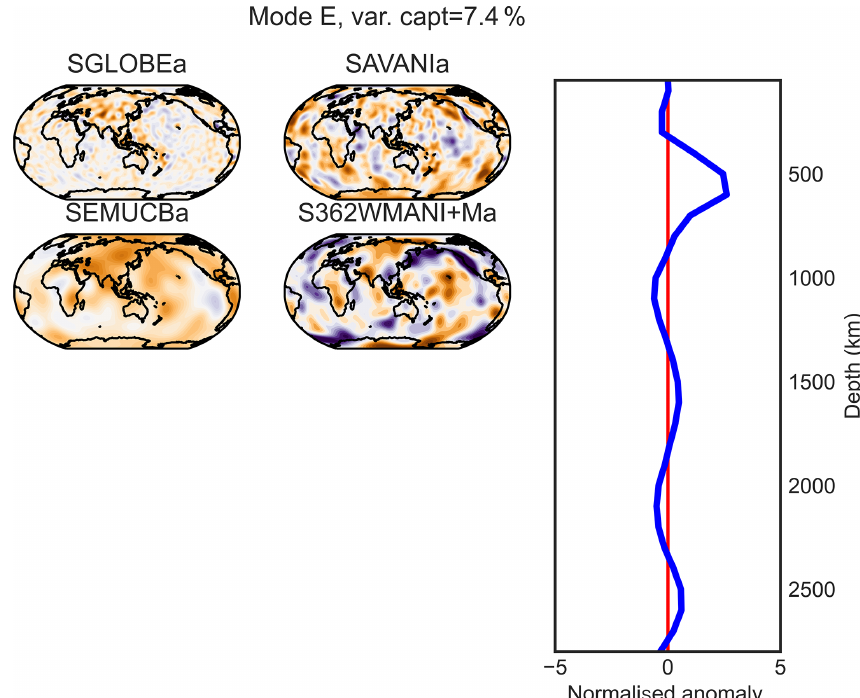
Figure E5. PC E (maximum at 600km of depth) of the combined analysis of the anisotropic parts of the models.